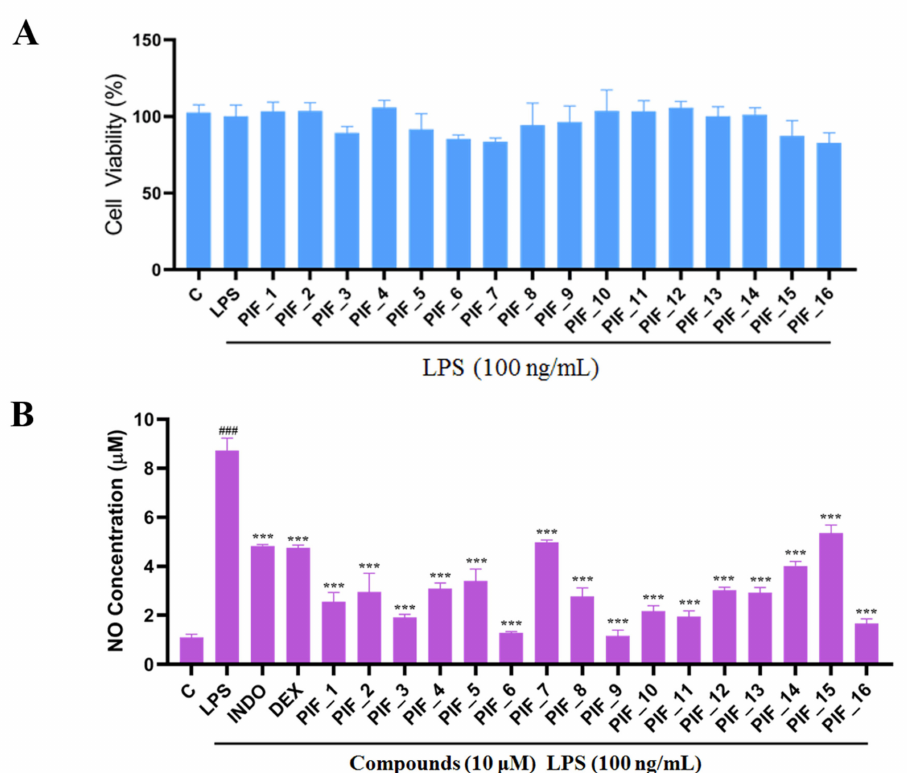
Figure 3. The ability of compounds to inhibit LPS-induced NO production in RAW264.7 macrophages. ( A ) The cytotoxic evaluation in RAW264.7 of compounds. RAW264.7 cells in a 96-plate cultured with serum-free medium were pre-incubated with all compounds (10 µ M) for 1 h, then washed with PBS followed by MTT determination as described in Materials and Methods. ( B ) Inhibition NO production by compounds with low cytotoxicity. RAW264.7 cells in a 96-plate cultured with serum-free medium were pretreated with compounds (10 µ M) for 1 h and co-treated with LPS (100 ng/mL) for 24 h. Cellular medium were collected for NO determination as described in Materials and Methods. INDO: positive control Indomethacin. DEX: positive control Dexamethasone. ### , p < 0.001 vs. Control; ***, p < 0.001 vs. LPS-treated